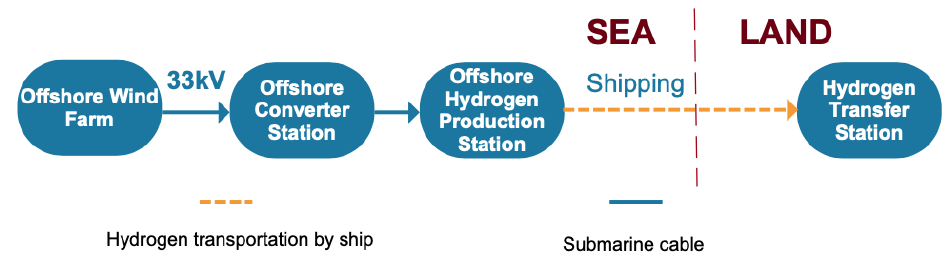
Figure 6. Topology of an offshore platform hydrogen production and ship hydrogen transportation system.